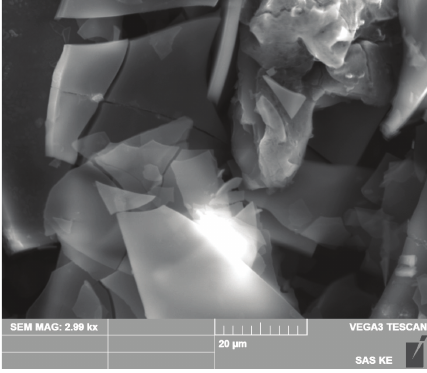
Figure 4: SEM image of Mn 0.8 Zn 0.2 Fe 2 O 4